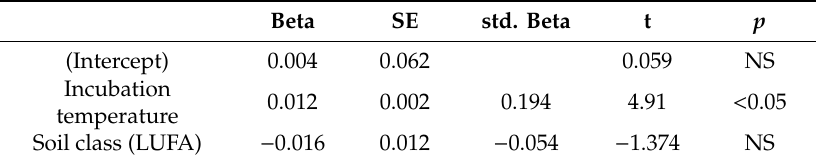
Table 4. Forward stepwise linear regression analysis of k for the parameters C to N ratio, C to N org ratio, N content of the fertilizer, moisture (in % maximum water holding capacity), incubation temperature, and soil class.